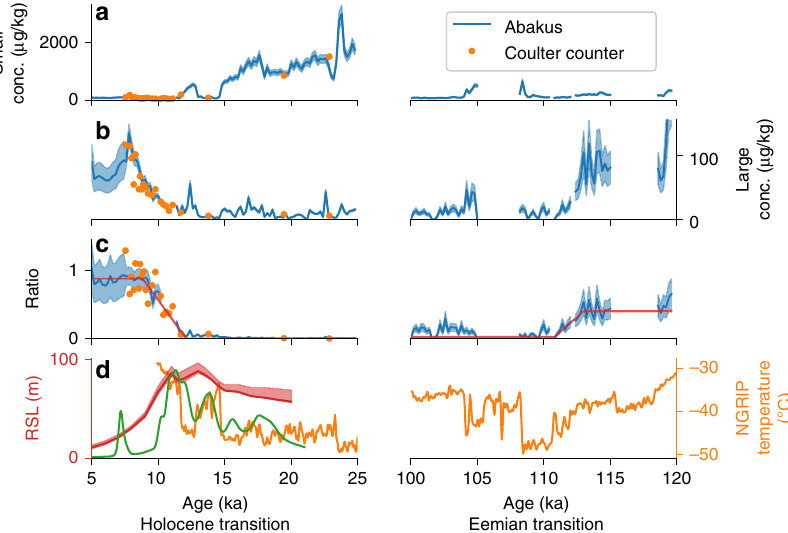
Fig. 4 Glacial-interglacial transitions in RECAP dust. The small (1.25 – 2.9 μ m) ( a ) and large (8.13 – 10.5 μ m) ( b ) particle concentration and the ratio ( c ) between the large and small particle concentrations found in RECAP ice core are shown. 200 year means are shown for dust particle sizes measured by an Abakus laser particle sensor from Klotz GmbH, Germany (blue) together with 55 cm Coulter Counter samples (orange) and a piecewise continuous ramp fi t function applied to the Abakus data (red). The blue shadings around the curves are 1 σ errors. d NGRIP temperature (orange), relative sea level in Scoresby Sund (red) 45 and probability density function (PDF) of deglacial 10 Be ages for the Scoresby Sund region 43 (green). The deglacial 10 Be PDF shows the number of rock exposure timing measurements in the Scoresby Sund region through the glacial